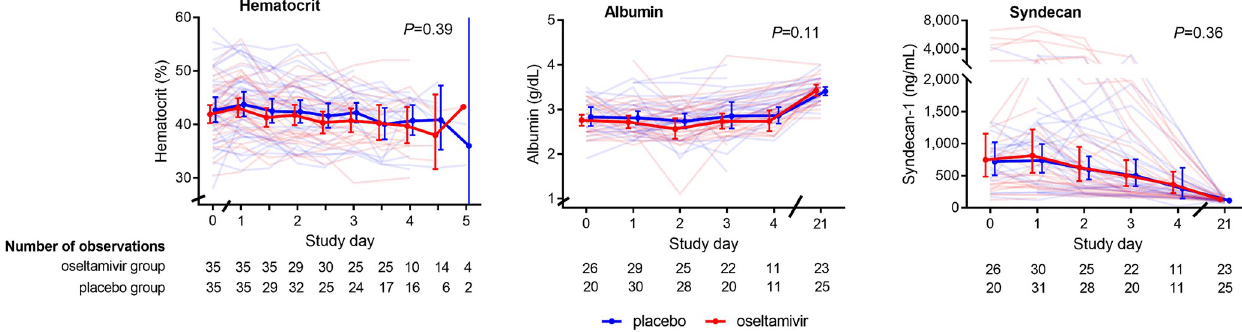
Fig 3. Daily hematocrite, serum albumin and syndecan-1 concetrations. Data depicted are individual values (transparent lines) and geometric mean (solid line) with 95% confidence interval. P value calculated using mixed model method.